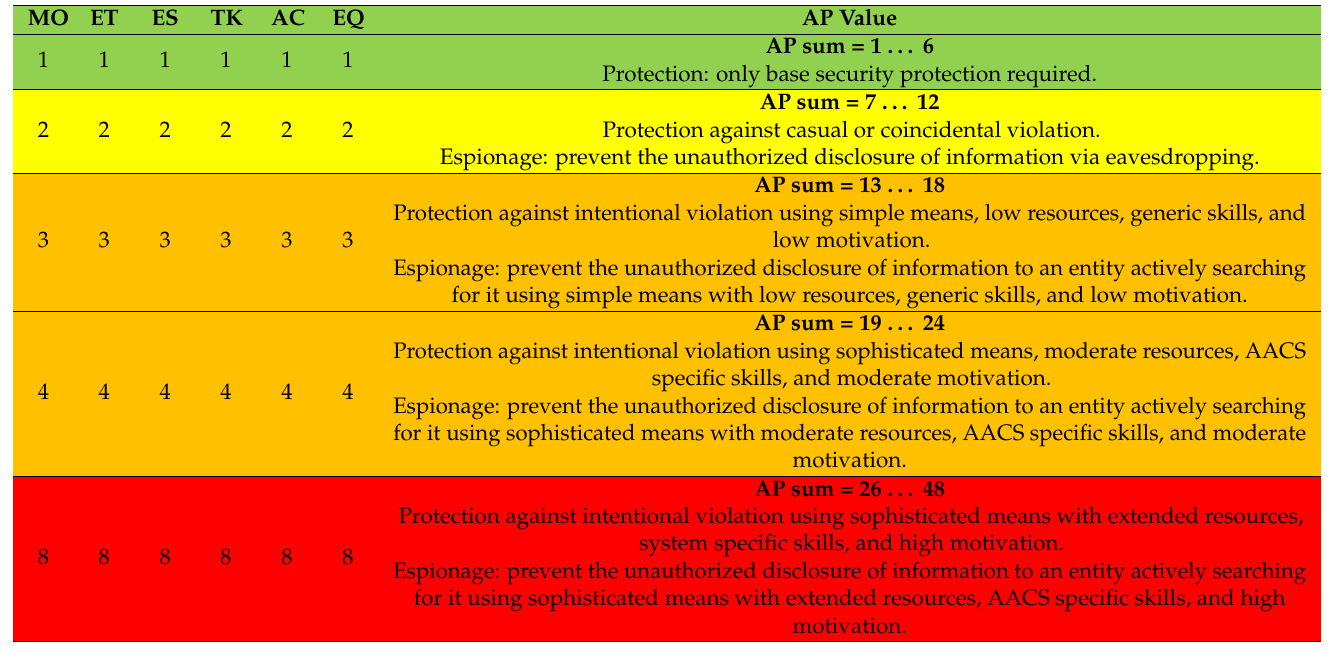
Table 12. Cybersecurity: AP value